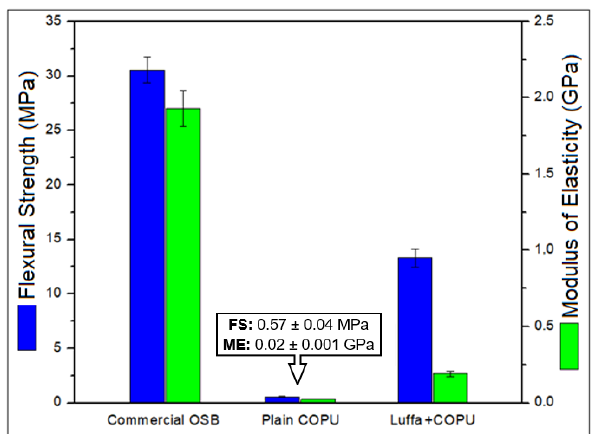
Figure 2. Flexural strength (FS) and flexural modulus of elasticity (ME) properties for the tested materials. tested